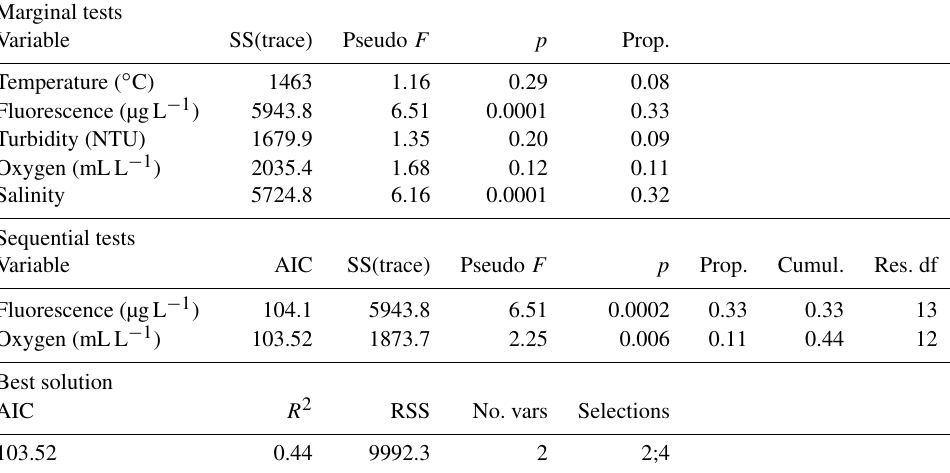
Table 1. Results of the marginal and the sequential test for the DistLM model, with an indication of the best model. AIC: Akaike information criterion, Cumul.: cumulative, No. vars: number of variables, Prop.: proportion of variation explained by each variable, Res. df: residual degrees of freedom, RSS: residual sum of squares, SS(trace): portion of sum of squares relative to the analysed predictor